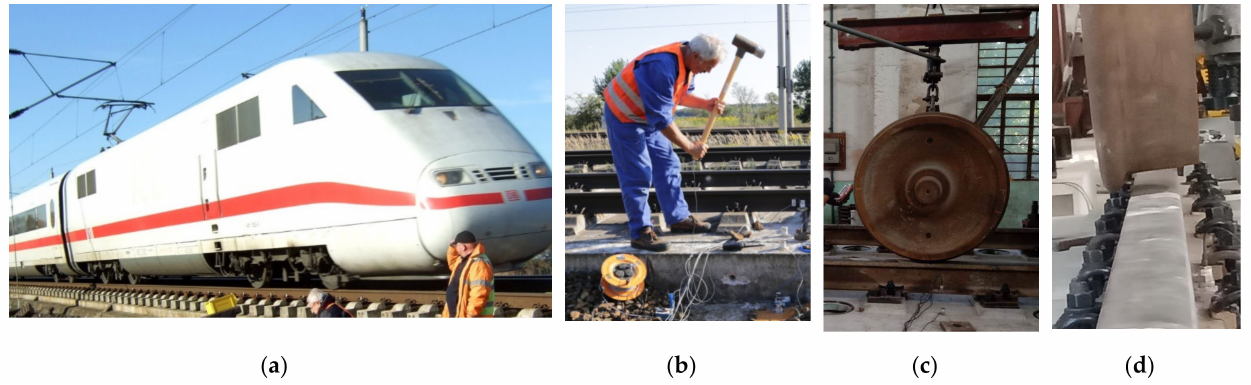
Figure 1. Experimental methods for identifying track properties and damage: ( a ) train passage at Site G; ( b ) hammer impacts at Site W; ( c , d ) wheelset drop tests at Site